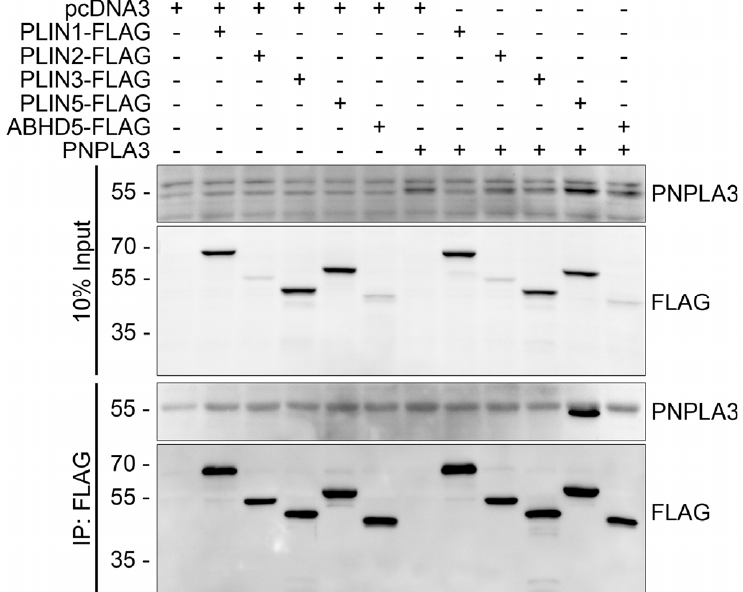
Figure A3. Co-precipitation of PLIN5 with PNPLA3 in the human hepatoma cell line Huh7. Immunoblot analysis of PNPLA3 in co-immunoprecipitates of FLAG-tag in Huh7 cells transfected with PNPLA3 alone or together with FLAG-tagged PLIN1, 2, 3, 5 or ABHD5. As already shown for HEK293T cells, PNPLA3 co-immunoprecipitates only with perilipin 5 (PLIN5), but no other perilipin. Molecular weight in kDa is given on the left.